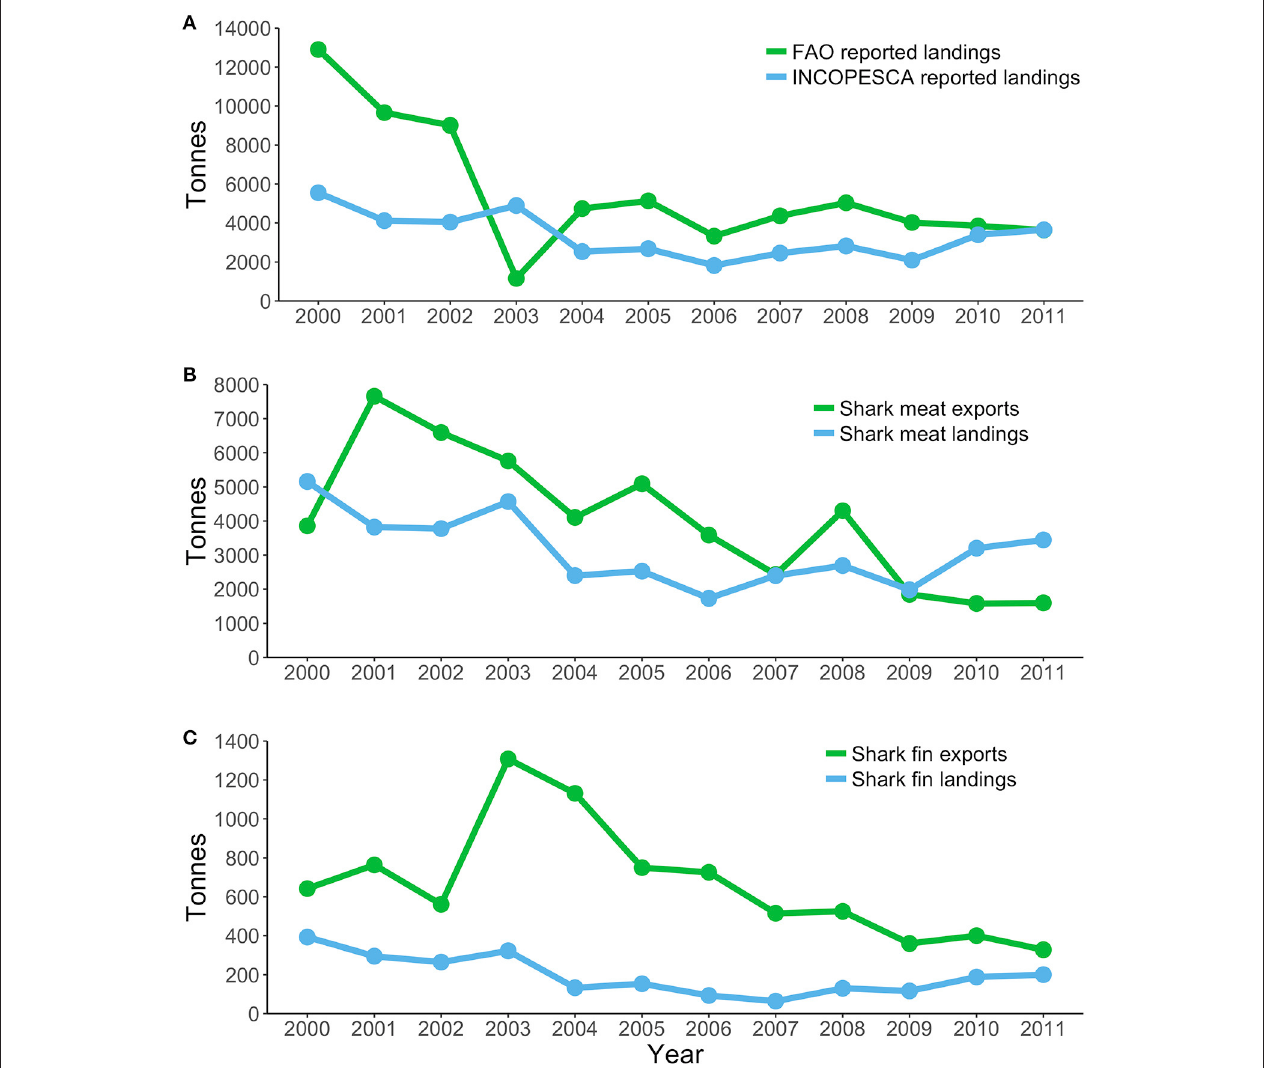
FIGURE 5 | Fisheries landings and exports of shark products in Costa Rica during 2000–2011. (A) Landings reported by FAO and landings reported by the Costa Rican Fishing Institute (INCOPESCA). (B) Shark meat exports reported by Dent and Clarke (2015) and shark meat landings (INCOPESCA). (C) Shark fin landings estimated by Dent and Clarke (2015) and shark fin landings